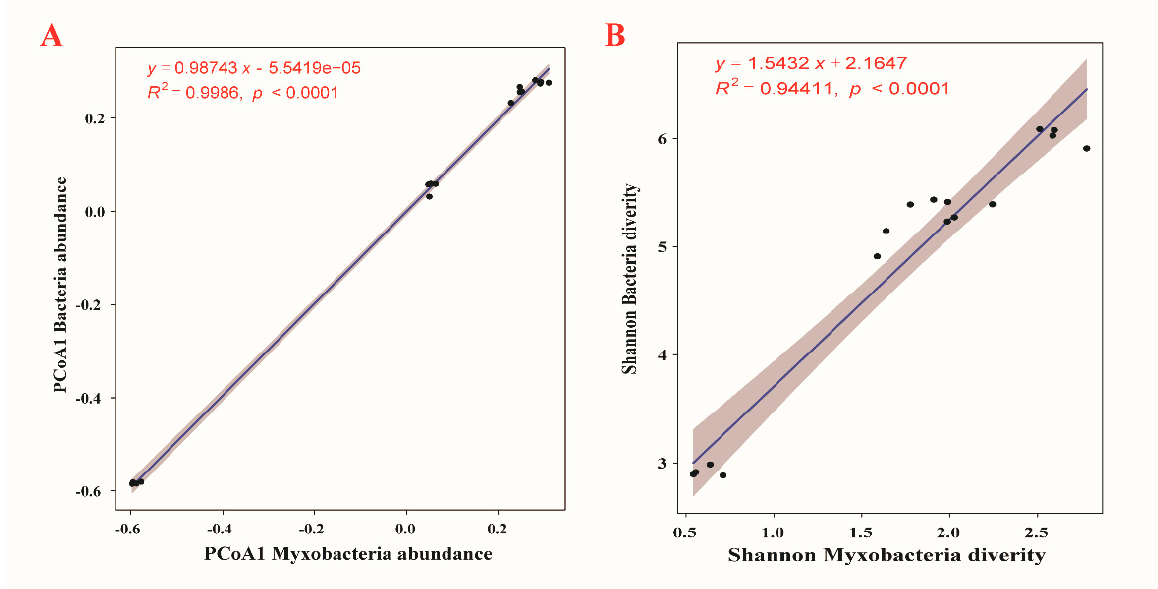
Figure 4. Relationship between myxobacteria and bacterial community abundance ( A ) and diversity ( B ) within four types of compost manure.